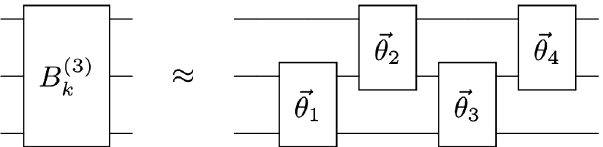
FIG. 11. The ansatz that we numerically optimize to approx- 3 Þ Z ð 3 Þ imately diagonalize S ð k and k . The two-qubit gates para- ⃗ θ ’ s are arbitrary two-qubit gates. We perform the metrized by the i numerical optimization using the JULIA